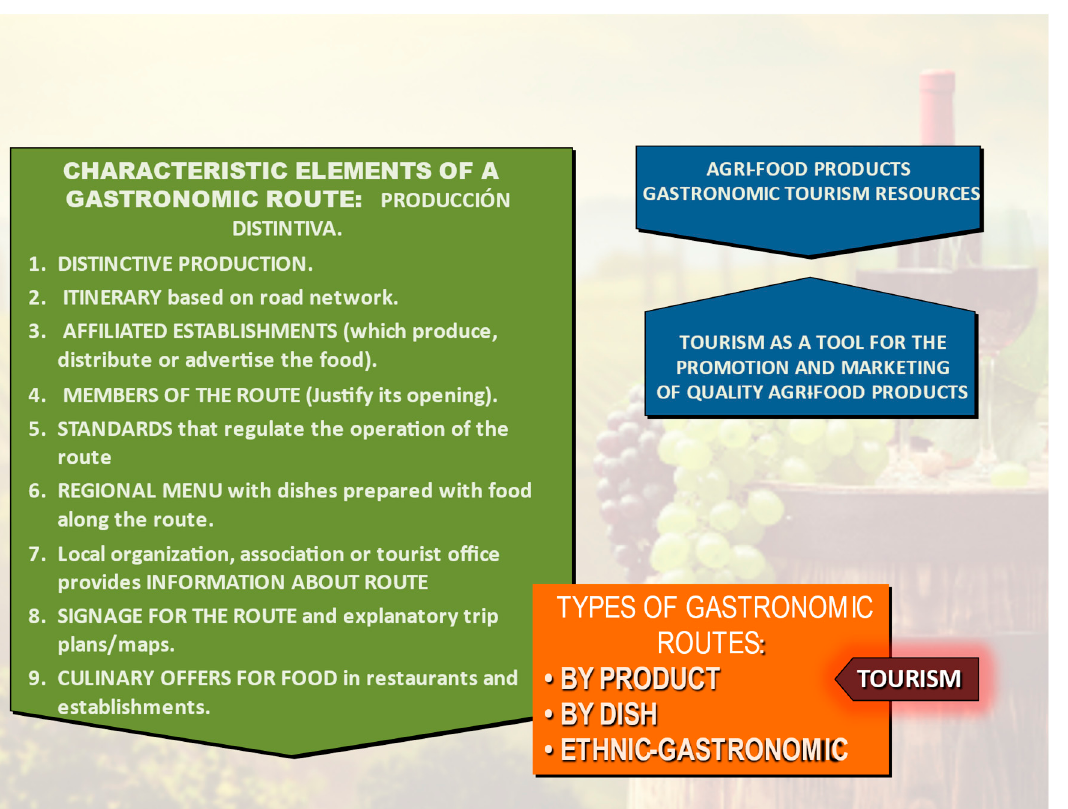
Table 1. Protected designations of origin and protected geographical indications of Spain (year 2021).